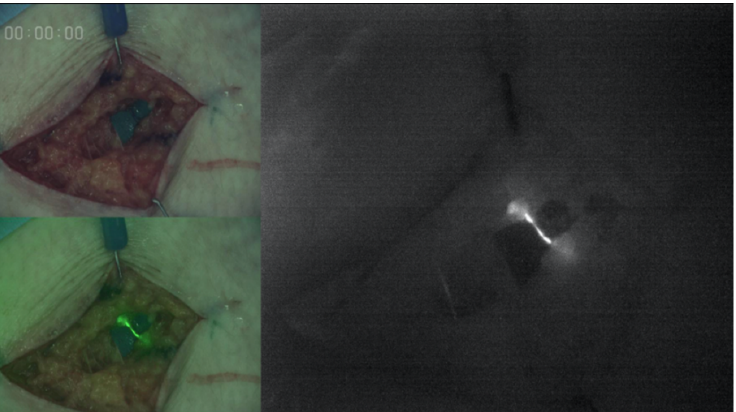
Figure 1. The lymphatic vessel was identified using an infrared camera system (LIGHTVISION; Shimazu Corporation, Kyoto, Japan) before the anastomosis. The anastomoses were performed with either the conventional technique or the suture- stent technique. After confirmation of the patency of the anastomosis site, the incision site was